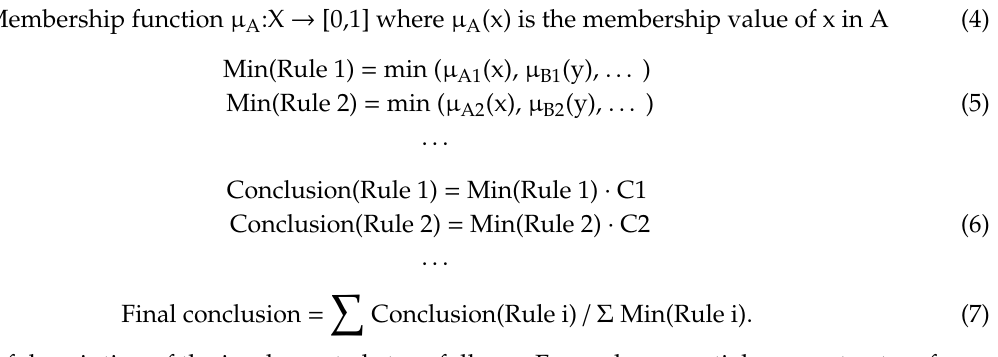
Table 3. Fuzzy sets and membership functions for the key geospatial parameters.